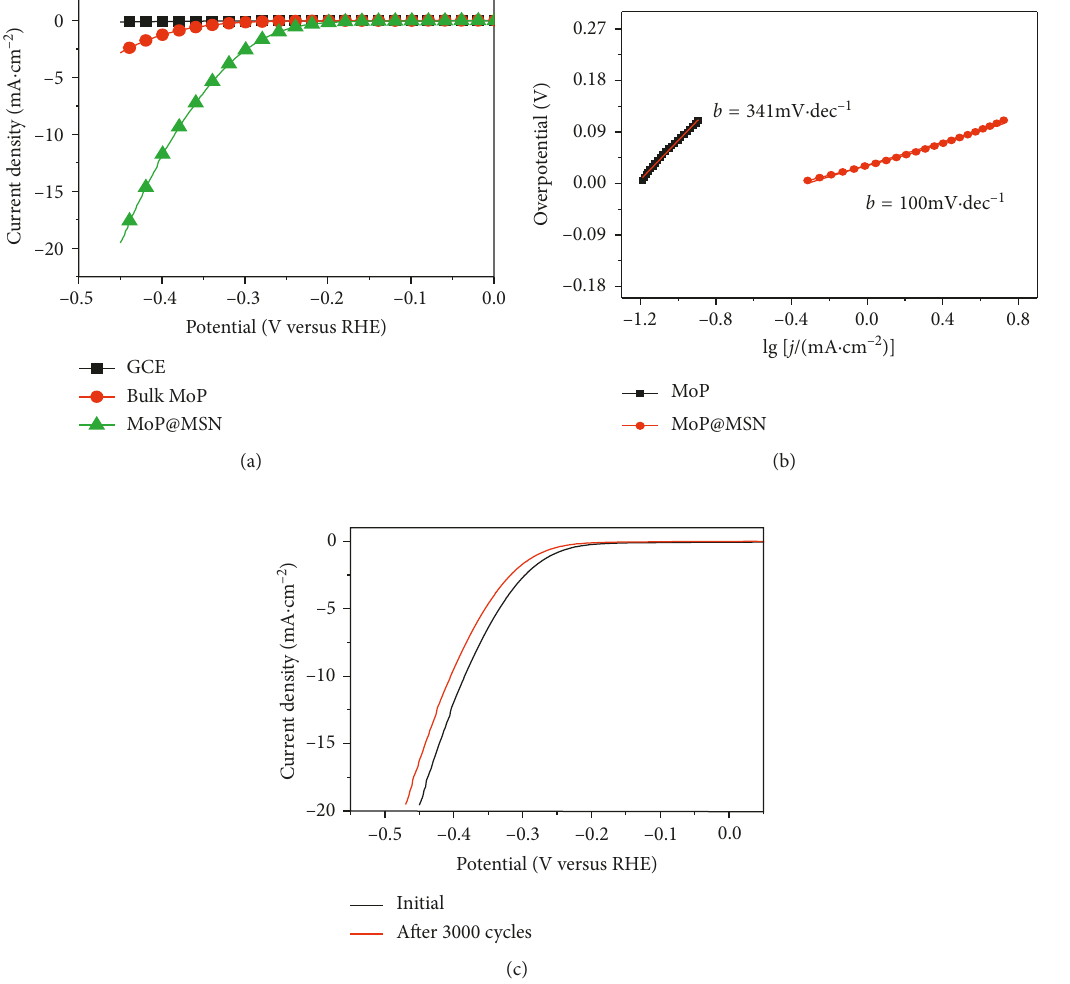
Figure 4: (a) Polarization curves of GCE, pure MoP, and MoP@MSN; (b) the Tafel plots of MoP and MoP@MSN after iR correction; (c) the stability test of the MoP@MSN